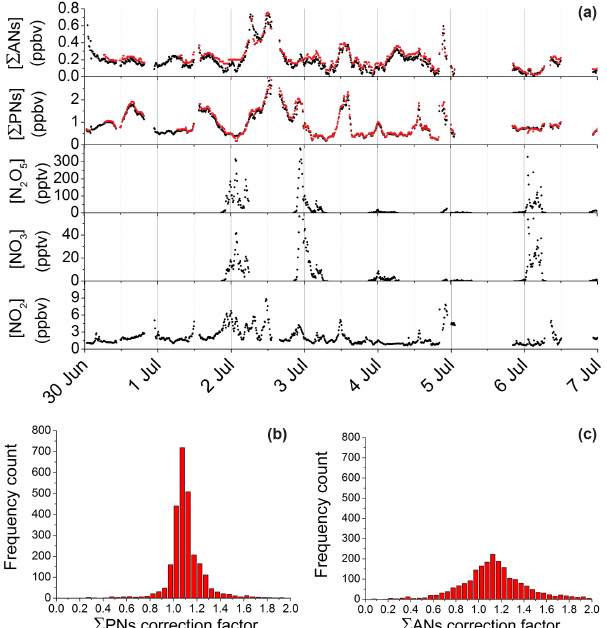
Figure 10. (a) Mixing ratios of NO 2 , NO 3 , N 2 O 5 , (cid:54) PNs and (cid:54) ANs measured by the TD-CRDS instrument between 30 June and 7 July 2015 at the Kleiner Feldberg observatory, Germany, as part of the NOTOMO campaign. For the three lowest panels in ([NO 2 ], [NO 3 ] and [N 2 O 5 ], the black points represent the final corrected data. For the (cid:54) PNs panel, the black points correspond to uncor- rected data obtained by subtracting [NO 2 ] measured in the NO 2 channel from the NO 2 measured in the (cid:54) PNs channel. The red points have been corrected using the chemical model with the it- erative fitting procedure. For the (cid:54) ANs panel, the black points cor- respond to the uncorrected data (obtained by subtracting the NO 2 signal measured in the (cid:54) PNs channel from the NO 2 signal mea- sured in the (cid:54) ANs channel). The red points have been corrected using the chemical model plus iterative fitting procedure. Panels (b) and (c) are frequency distributions for the correction factors applied using the iterative numerical simulations.